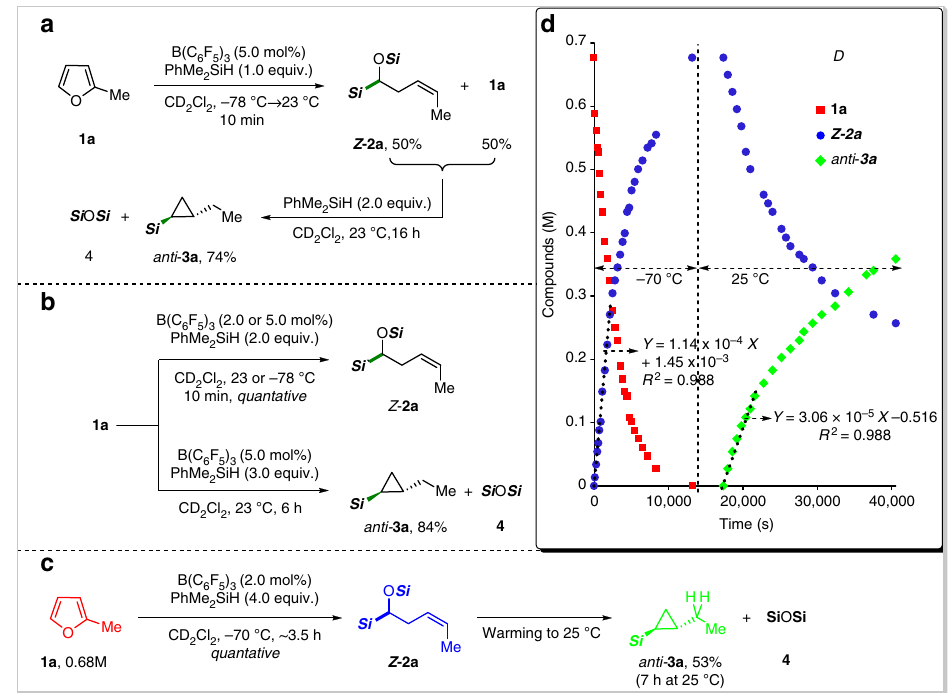
Figure 2 | Preliminary catalytic reactions and NMR monitoring. ( a ) Sequential addition of hydrosilane. ( b ) Control of product distribution by the equivalents of hydrosilane. ( c ) Ring-opening and closing transformations of 2-methylfuran in one flask. ( d ) NMR monitoring of the B(C 6 F 5 ) 3 -catalyzed cascade conversion of 2-methylfuran with hydrosilane. ( Si ¼ SiMe 2 products bearing sp 3 C (cid:2) Si bonds (Table 2). Unsubstituted furan